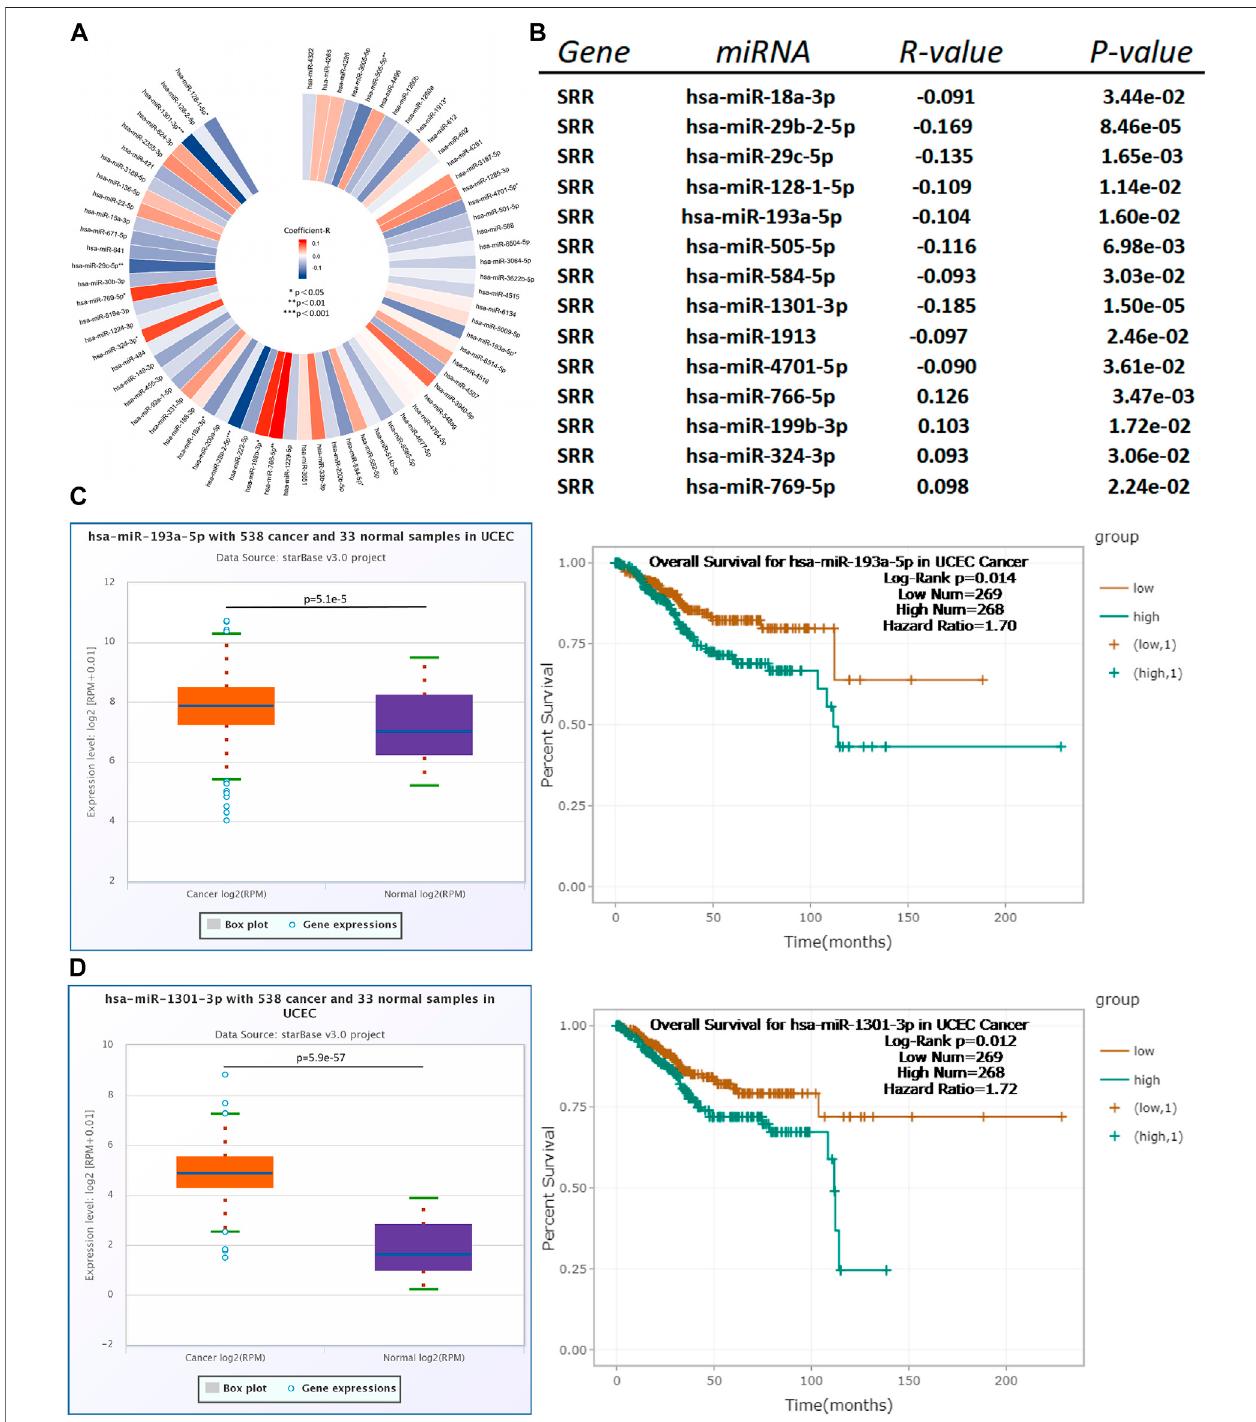
FIGURE 10 | Identi fi cation of hsa-miR-193a-5p and hsa-miR-1301-3p as the most potential upstream miRNAs of SRR in UCEC. (A) A miRNA-SRR regulatory network in UCEC is constructed. (B) A total of 14 miRNAs showing signi fi cant correlations with SRR in UCEC are discovered by StarBase. Expression and survival analysis of hsa-miR-193a-5p (C) and hsa-miR-1301-3p (D) in UCEC patients conducted through StarBase.